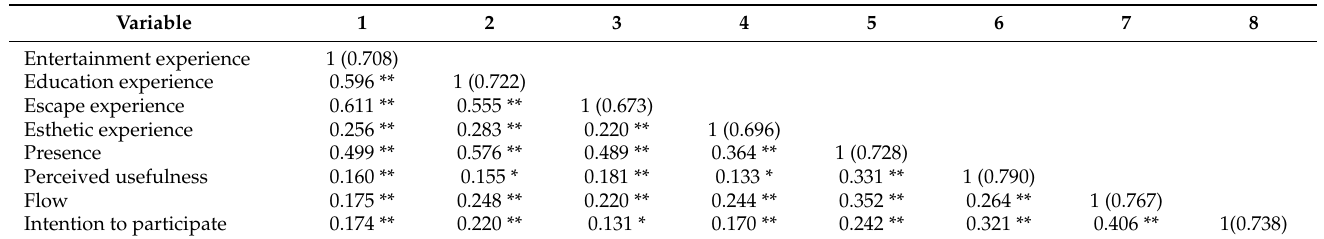
Table 5. Correlation analysis among variables.